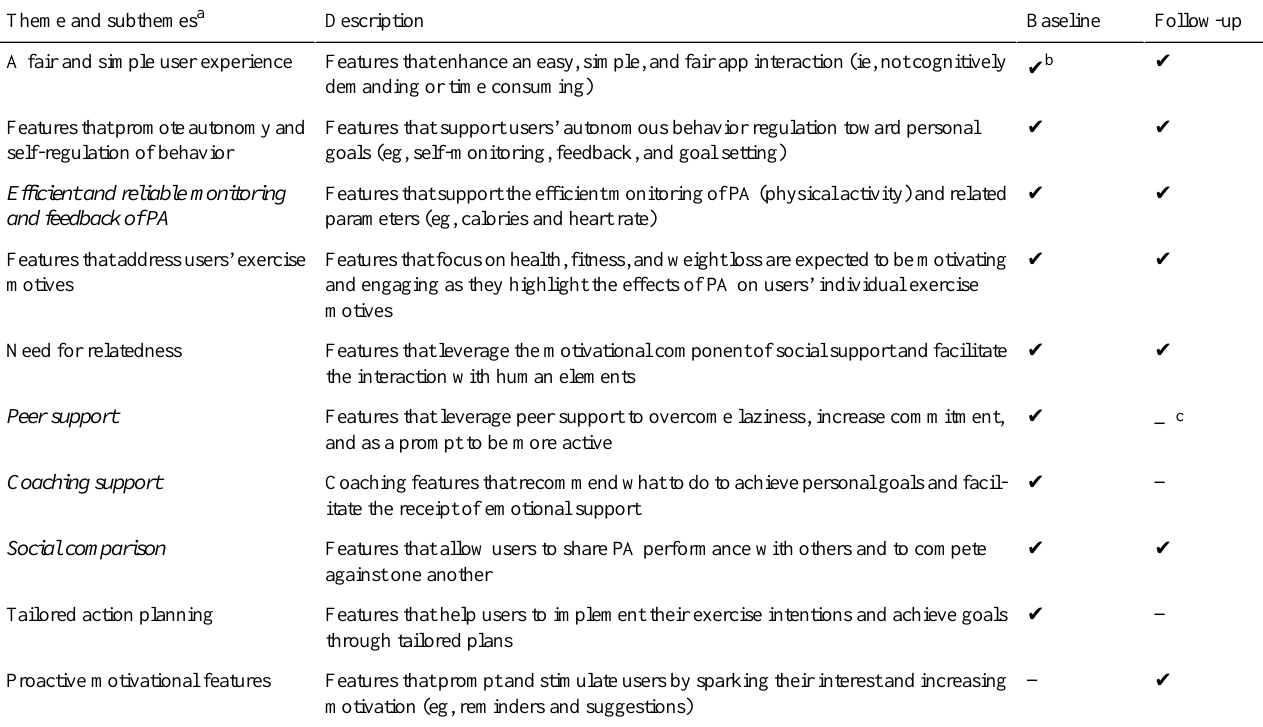
Table 3. Summary of themes and subthemes identified in (1) the baseline interviews and (2) the follow-up interviews. Follow-upBaselineDescriptionTheme and subthemes a consuming)A fair and simple user experience